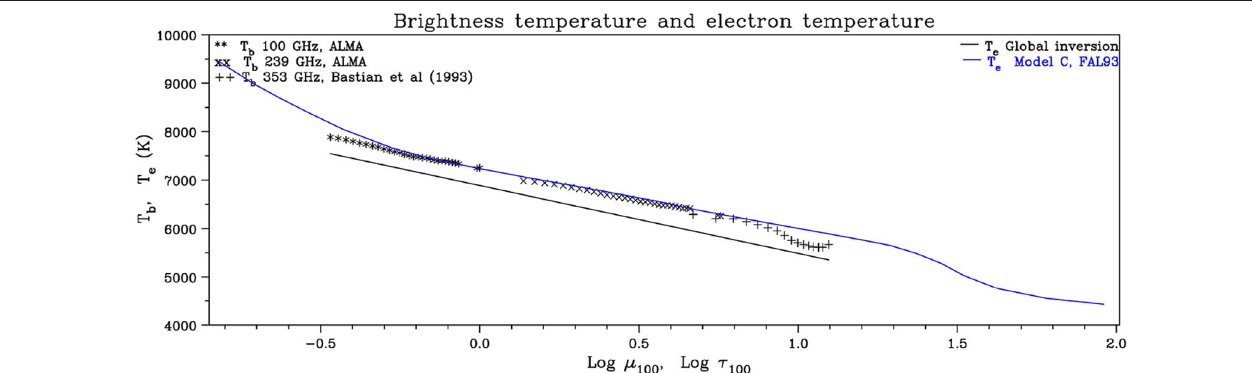
FIGURE 2 | Observed brightness temperature in the mm- λ range, T b as a function of the cosine of heliocentric angle, µ 100 , reduced to 100MHz (symbols). The same plot shows the computed electron temperature, T e as a function of the optical depth, τ 100 , (black line), again reduced to 100GHz. The blue line gives T e ( τ 100 ) predicted by model C of Fontenla et al. (1993). Note that increasing τ corresponds to decreasing altitude in the atmosphere. Adapted from Alissandrakis et al. (2017), reproduced with permission © ESO.